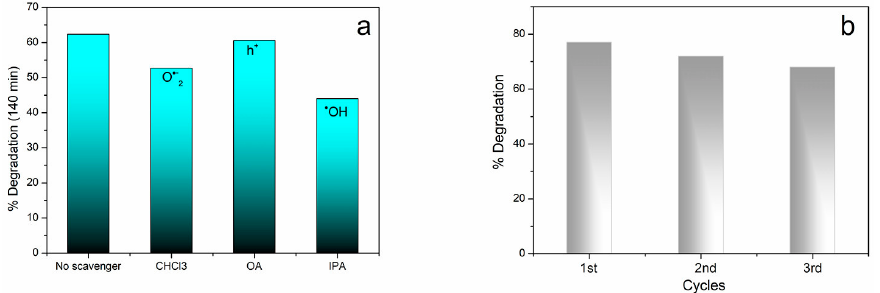
Figure 5. ( a ) Photocatalytic degradation of MB under solar simulated light after addition of several trapping reagents and ( b ) recycled test of MB photodegradation under solar simulated light of ZnO (stearic acid)/VOx-NTs 1:0.06.